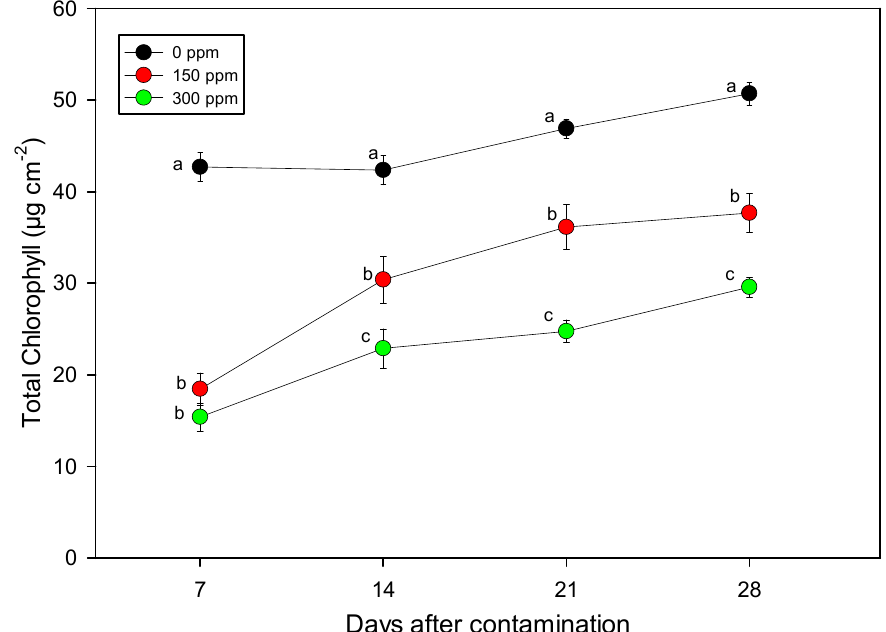
Figure 10. Time course of the chlorophyll content in Arundo plants treated with different copper concentrations (0, 150, and 300 ppm) for 28 days. Data points and vertical bars represent means (n = 8) ± S.E., respectively. One-way ANOVA was applied and for a given duration different letters indicate significant difference according to LSD test ( p ≤ 0.05).